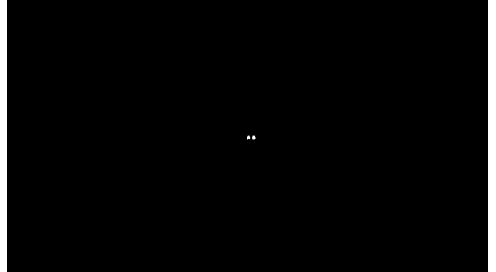
Figure 8. The picture containing red PAPI lights−the two white areas represent the two red PAPI lights. PAPI